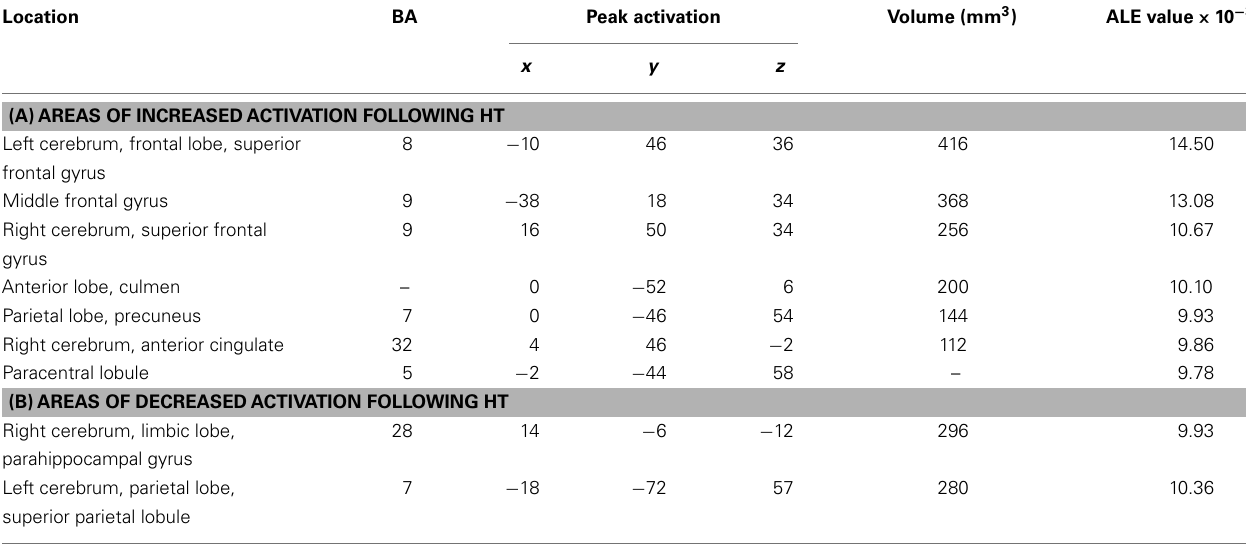
Table 2 | Results from theALE meta-analysis of treatment effects on studies in postmenopausal women ( p < 0.05, FDR-corrected) .